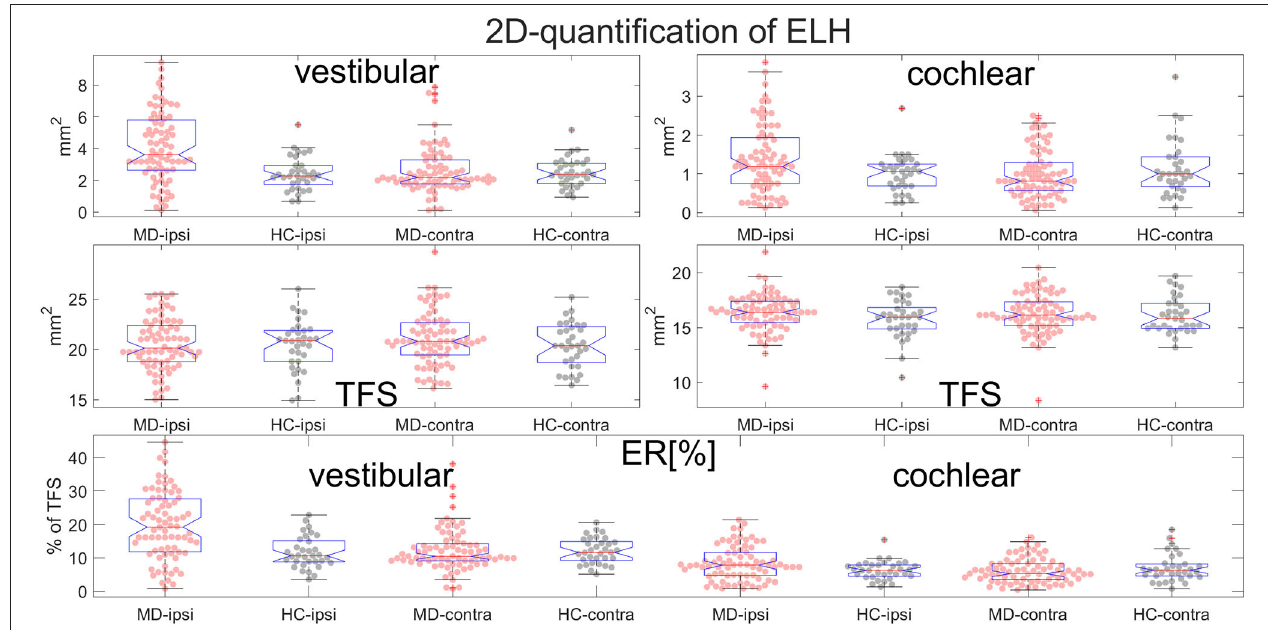
FIGURE 7 | Normalization and group differences for 2D-quantification of endolymphatic hydrops (ELH). 2D-quantification values of endolymphatic hydrops (ELH) in the vestibular and cochlear part of the inner ear, in [mm 2 ] (top row). 2D-quantification values of the total fluid surface (TFS) of the vestibular and cochlear part of the inner ear, in [mm 2 ] (middle row) that were used for normalizing the data of each individual to ELS ratio (ER) [%], the percentage of the TFS occupied by the ELH (bottom row).